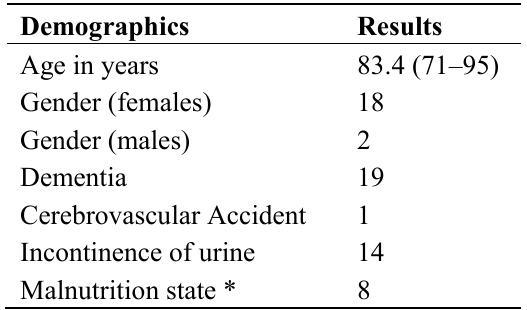
Table 1. Demographics of participating residents.